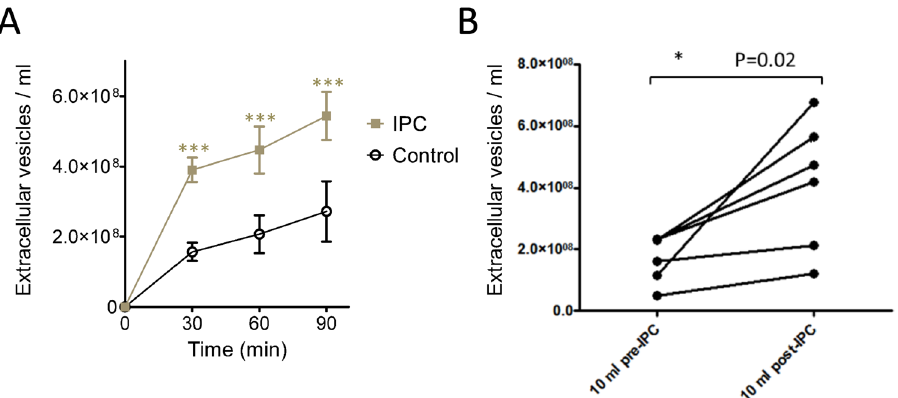
Figure 4. Ischaemic preconditioning (IPC) increases the release of EVs. ( A ) The increase in exosome concentration in HUVEC culture medium over time (N = 3). ( B ) Ischaemic preconditioning of Langendorff perfused hearts significantly increase the rate of exosome release measured after 10 min (N =